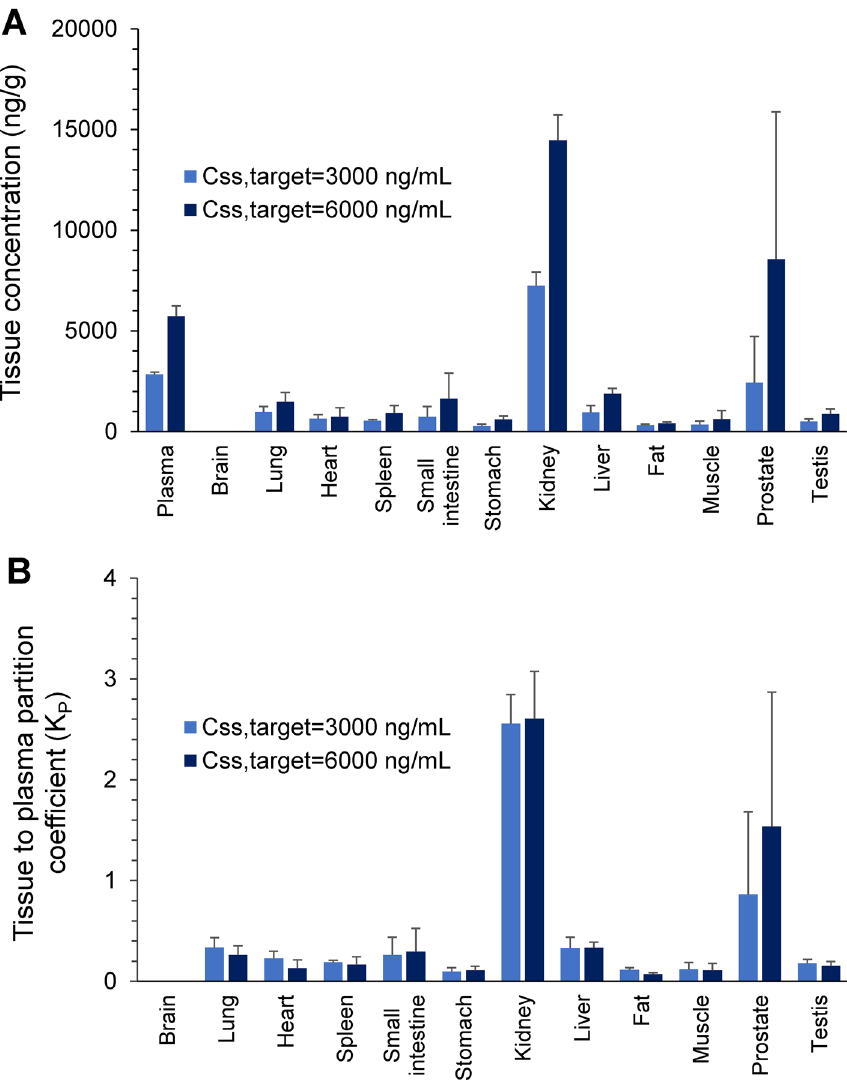
Figure 5. Average tissue concentrations (A) and tissue-to-plasma partition coefficients (K P ) of 175 Lu-DOTA- PSMA-GUL (B) obtained following continuous i.v. infusion (K 0 = 1.82 and 3.65 mg/h/kg) with i.v. bolus loading dose (LD = 0.60 and 1.20 mg/kg) in rats (n = 5,